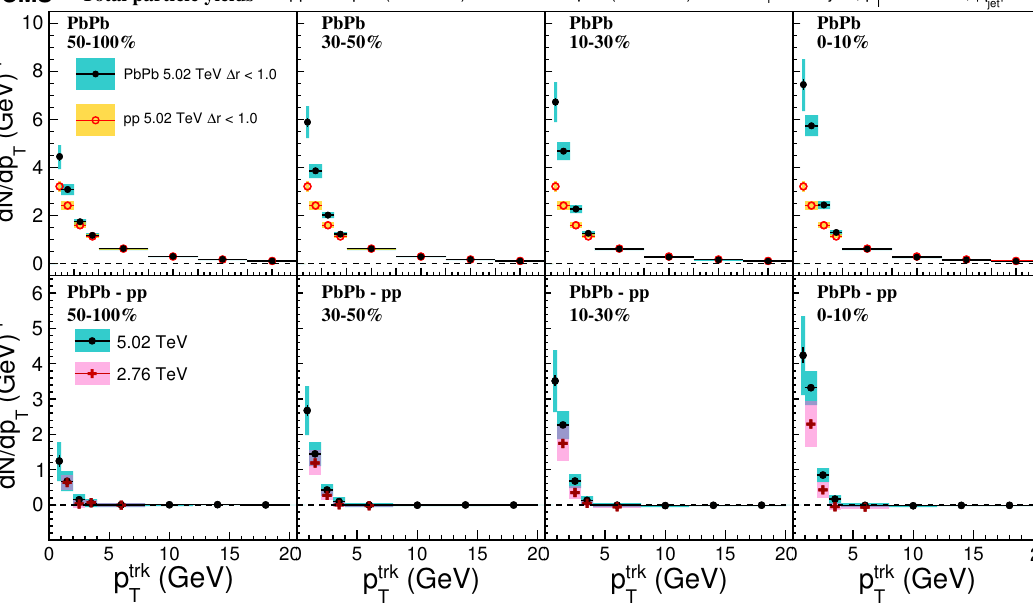
Figure 4 . The distribution of jet-correlated charged-particle tracks with (cid:1)r < 1 (top row) as a function of p trk in PbPb and pp collisions. The PbPb results are shown for di(cid:11)erent centrality T regions. Statistical uncertainties are shown by the vertical error bars and systematic uncertainties by the shaded boxes. The corresponding results for the di(cid:11)erence between the PbPb and pp data are shown in the bottom row, with the analogous di(cid:11)erence observed at 2.76 TeV